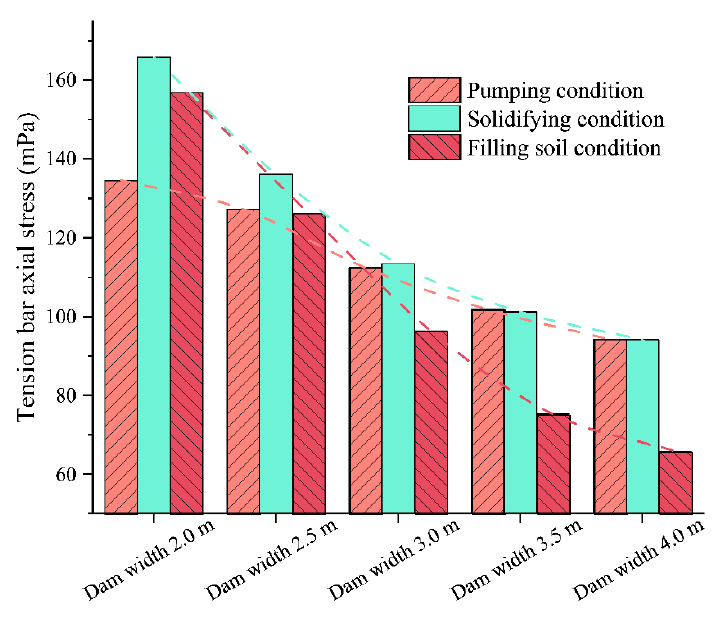
Figure 17. Tension bar axial stress of different dam width conditions.